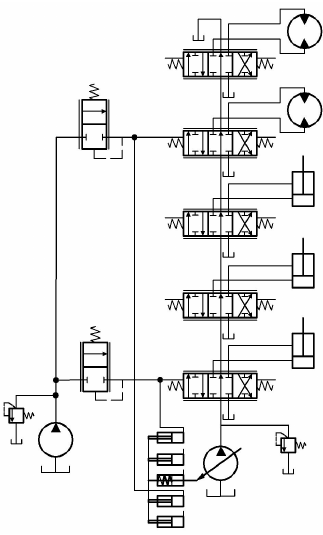
Figure 3. Synthetic pilot pressure positive flow-control system. Chen et al. [50] analyzed the energy loss path of the hydraulic system based on the basic principles and characteristics of the negative-flow hydraulic system. On the basis of